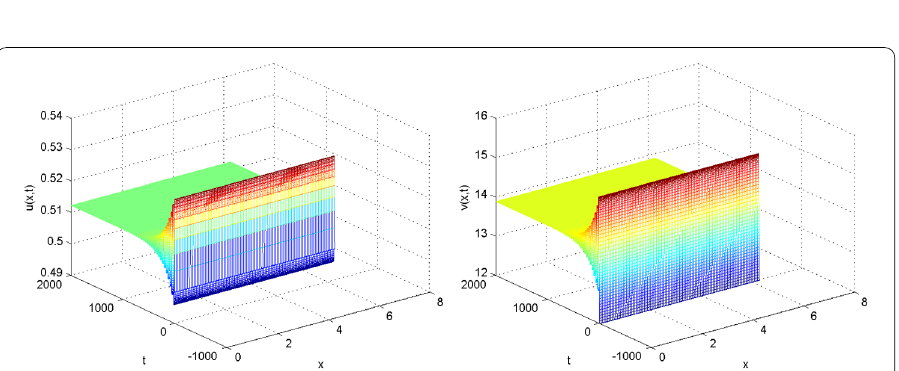
Figure 5 For system (1.3), τ = 8 and the initial condition is (0.5,12). Left component: u ( x , t ) (Stable). Right component: v ( x , t ) (Stable).